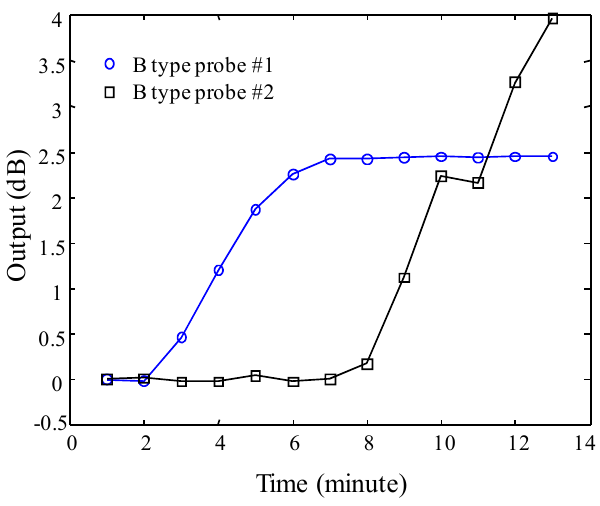
Figure 13. Sensor output of B-type as a function of water injection time.